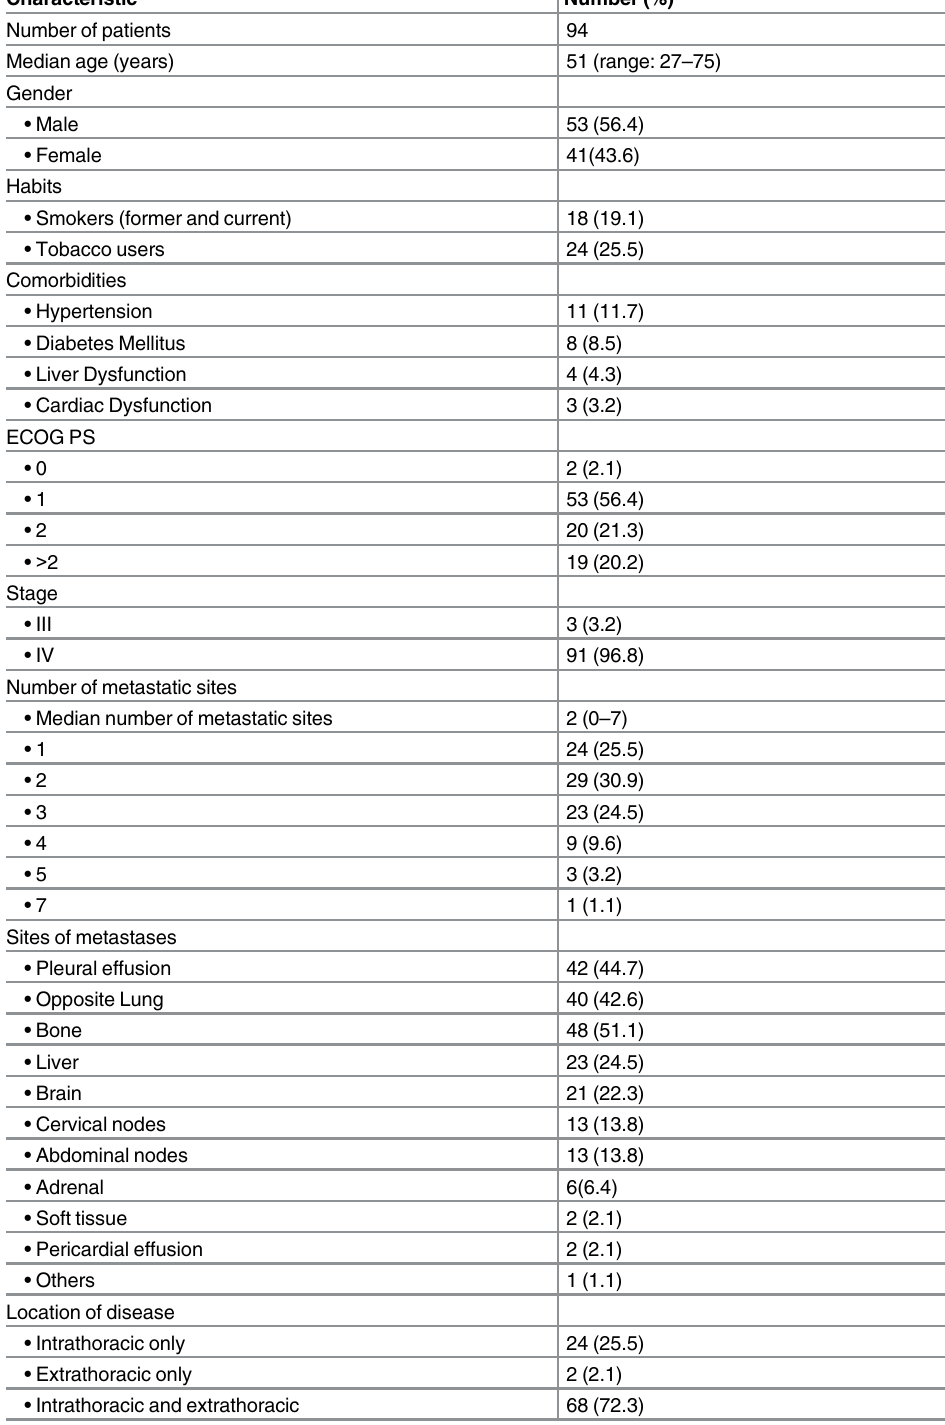
Table 1. Demographic Data and baseline tumor